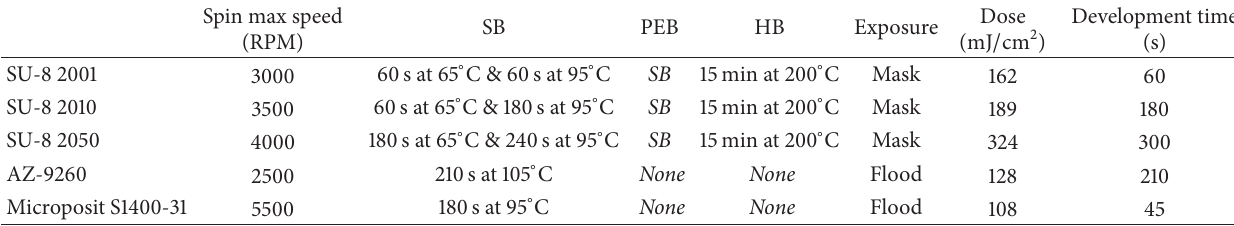
Table 1: Conditions for deposition and lithography of each